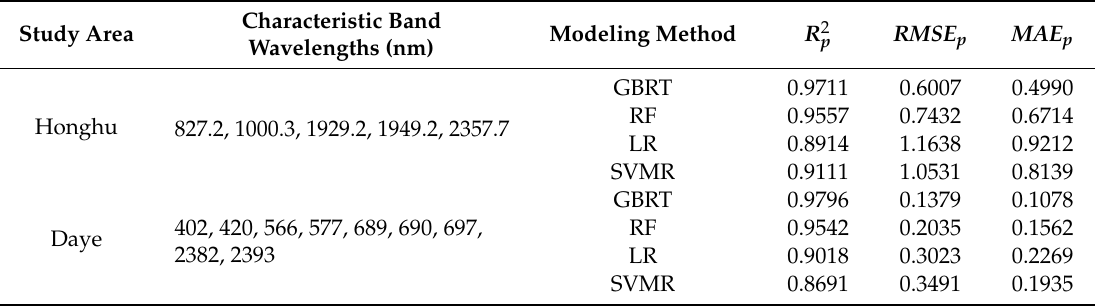
Table 3. Accuracy validation of the di ff erent